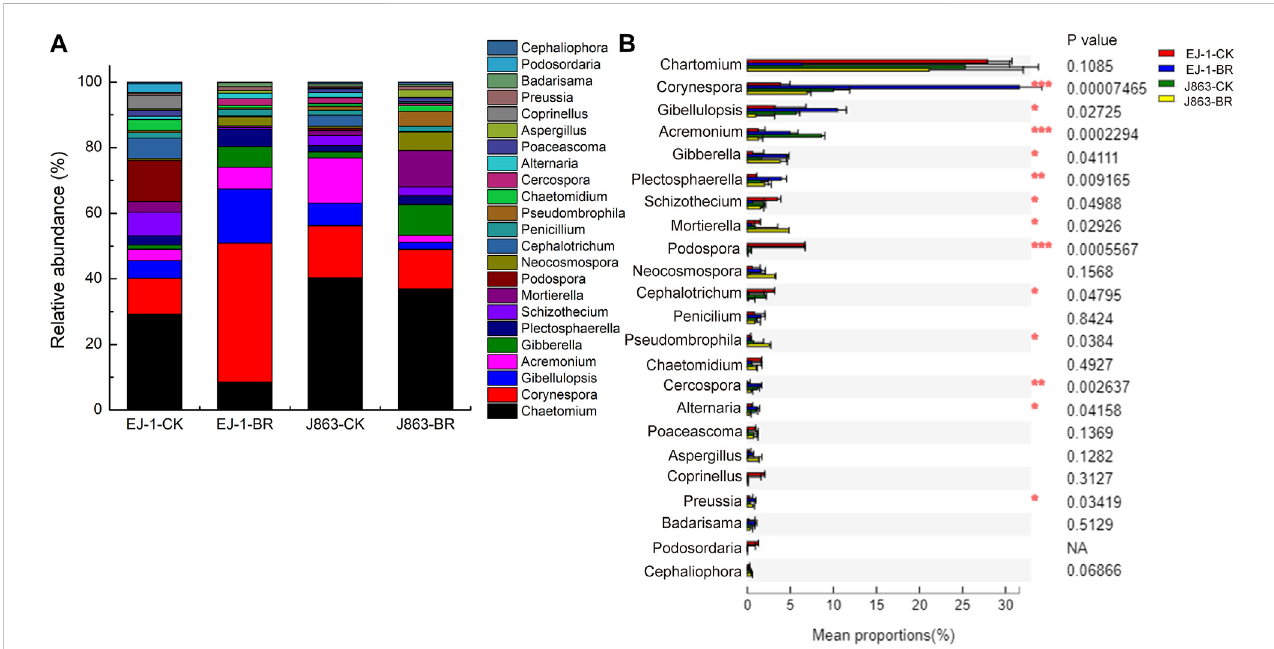
FIGURE 7 Changes in the relative abundances of the fungal taxa at the genus level in under different treatments. (A) Relative abundance of fungal (B) Analysis of signi fi cant differences in mean proportion of fungal. CK represents treatment with blank control, BR represents treatment with broccoli residues. EJ-1 represents susceptible cultivar for CVW, J863 represents resistant cultivar for CVW.